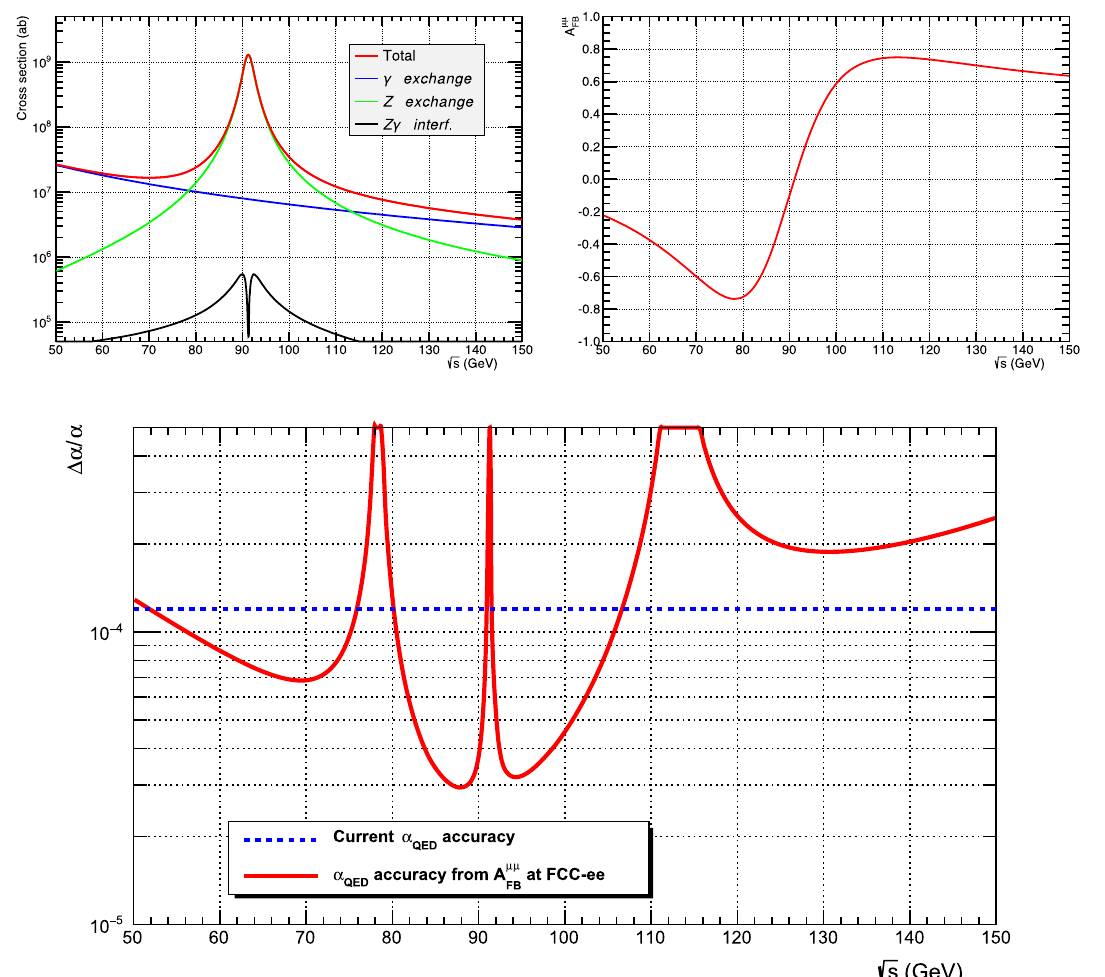
Fig. 3.1 Top row, left: the Z line shape with the Z and γ exchange contribution and the Z − γ interference. Top row, right: the muon pair forward–backward asymmetry has a strong slope around the Z-pole resulting from the Z - γ interference. Bottom row: relative statistical